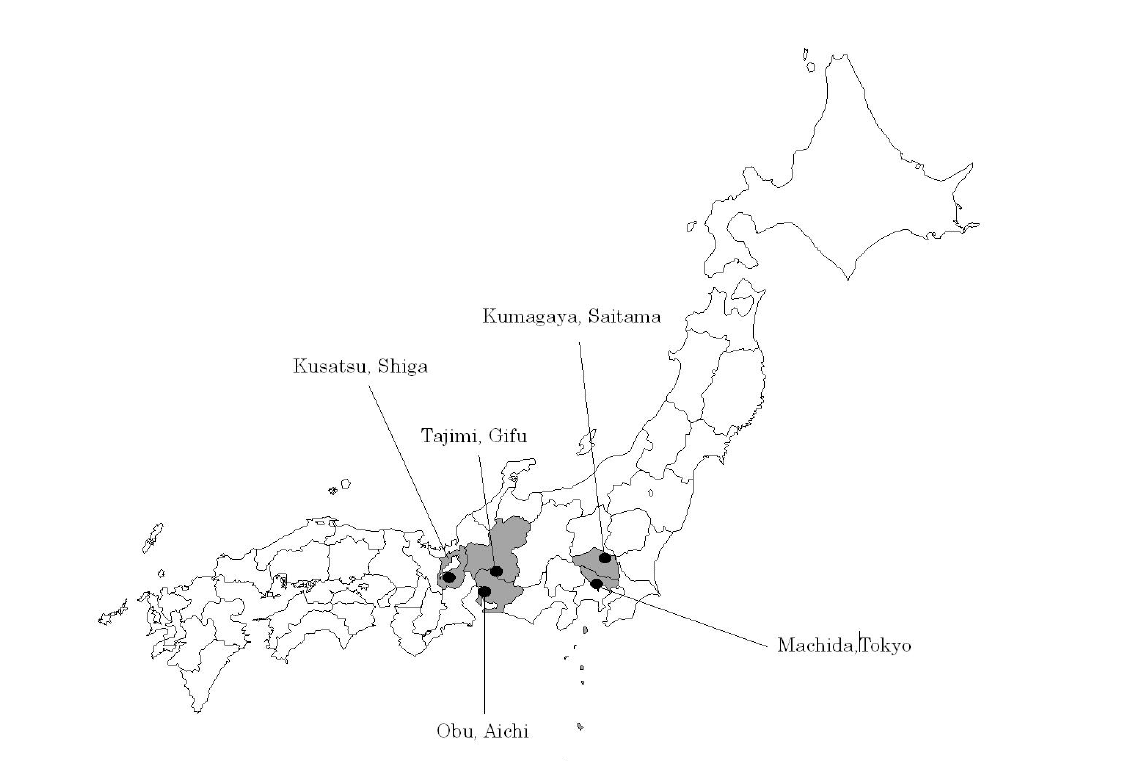
Source: adapted from